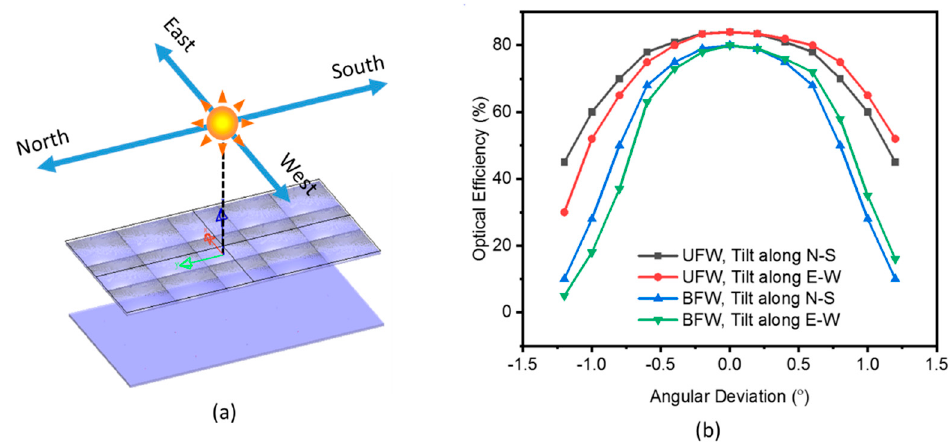
Figure 10. ( a ) The alignment of system along the North–South (N–S) and East–West (E–W) axes; ( b ) Variation of optical efficiency according to angular deviation along the N–S and E–W axes.